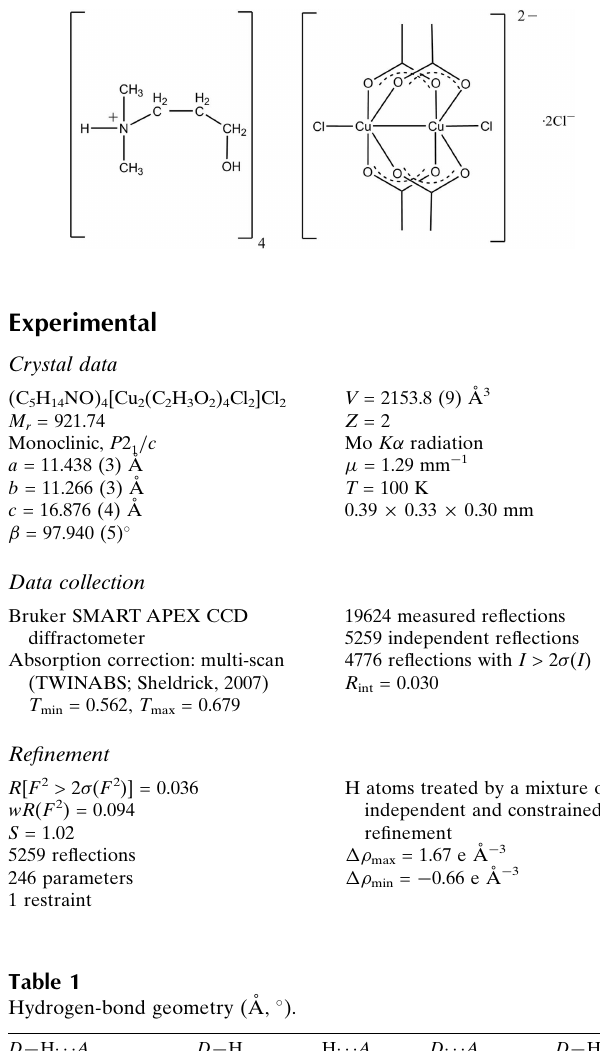
Hydrogen-bond geometry (A˚ , (cid:1) ). D —H (cid:2)(cid:2)(cid:2) A